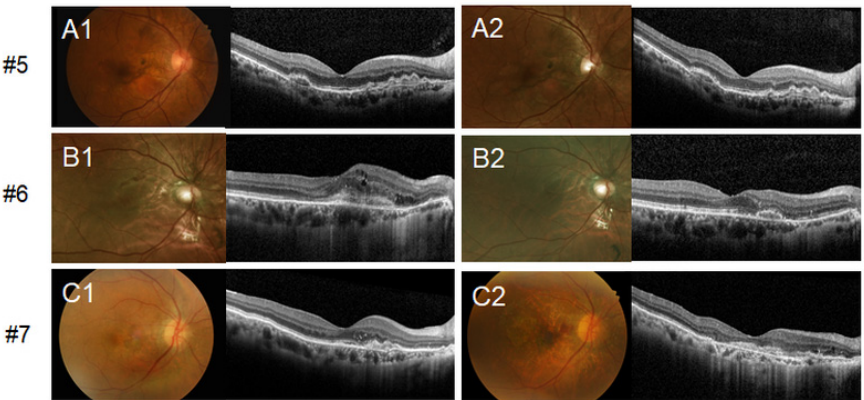
Figure 2. Changes in retinal phenotypes after the treatment of symptomatic patients (#5, #6, and #7). All symptomatic patients with choroidal neovascularization (CNV) were treated with intravitreal anti-vascular endothelial growth factor (anti-VEGF) injections. Only the right eyes of the patients are shown. Optical coherence tomography (OCT) of the right eye shows subretinal hyper-reflective tissue ( A1 – C1 ), which was confirmed as CNV by angiographic study. Reduction of subretinal CNV and absorption of subretinal fluid after intravitreal injections were noted ( A2 – C2 ). Patient #7 received 49 intravitreal injections in her right eye; subfoveal disciform scar with macular atrophy was observed consequently ( C2 ).